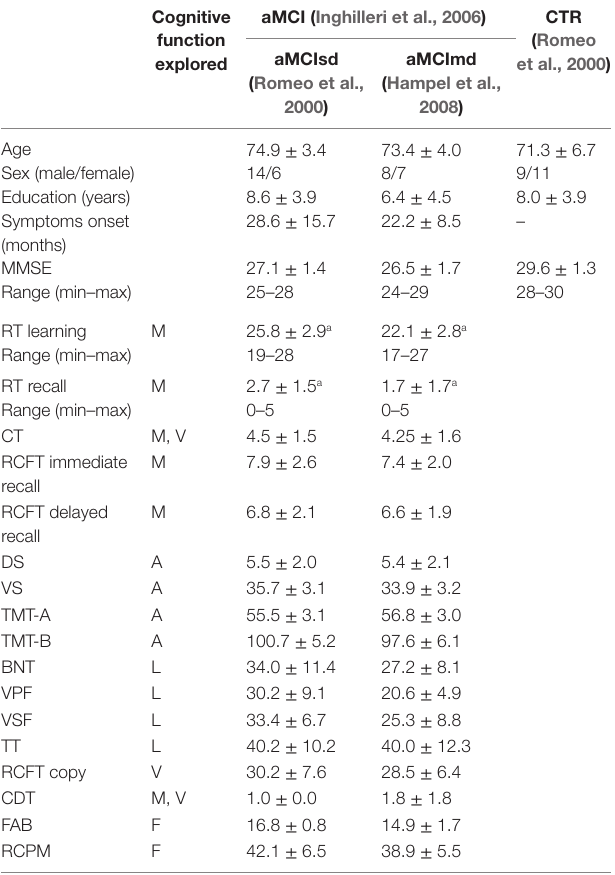
TaBle 1 | Demographic, clinical, and neuropsychological data of patients and controls (cTr) at baseline. cognitive function